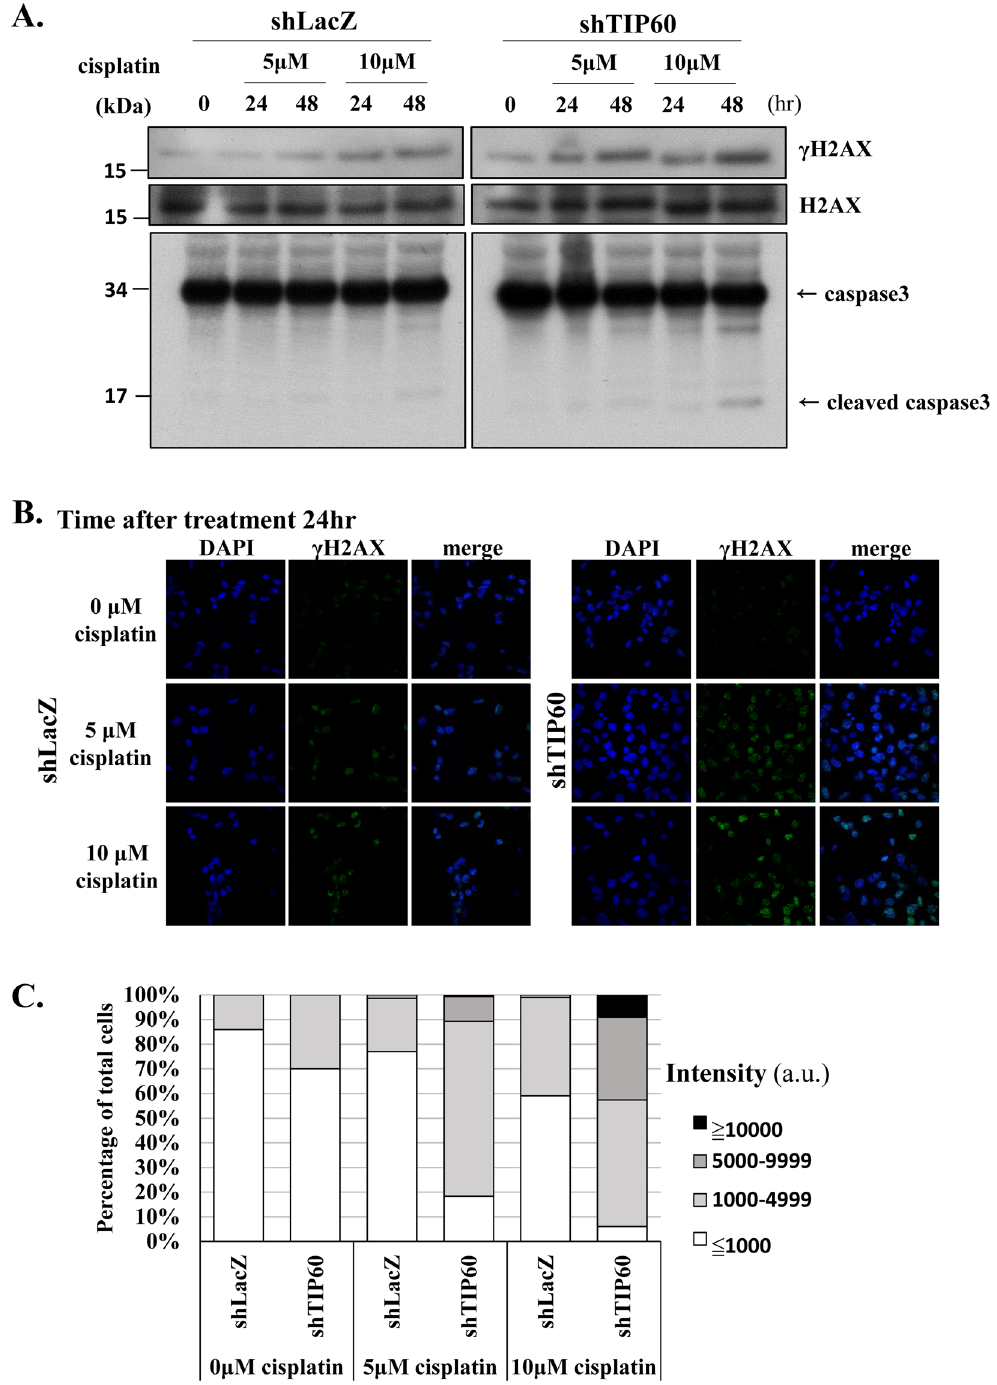
Figure 5. Cisplatin causes more severe DNA damage in TIP60-deficient cells. ( A ) Kinetics of DNA damage response in the control and TIP60-deficient cells. Cells were treated with 5 μ M or 10 μ M of cisplatin for 48 hours. Cells were harvested at the indicated time points and subjected to Western blotting with specific antibodies as indicated. The blotting of γ H2AX and H2AX was from the same membrane. Full-length blot is presented in Supplementary Figure S6. ( B ) Cells were chronically treated with 5 μΜ or 10 μΜ of cisplatin for 24 or 48 hours. Cells were fixed and immunostained with γ H2AX antibody. ( C ) The intensity of γ H2AX in each cell was quantified using an OLYMPUS FLUOVIE software. More than 300 cells of each cell line were